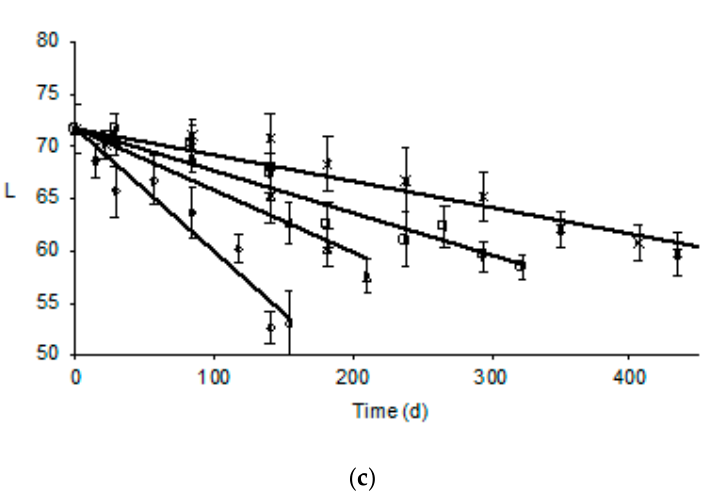
Figure 1. Changes of color ( L -value) of thawed ( a ) gilthead sea bream fillets, ( b ) sea bass fillets and ( c ) yellowfin tuna slices during storage at − 5, ∆ − 8, − 12 and ∗ − 15 °C. (Error bars indicate standard error of measurements of three different samples.) (1 a : R 2 − 5°C = 0.822, R 2 − 8°C = 0.820, R 2 − 12°C = 0.939, R 2 − 15°C = 0.937; 1 b : R 2 − 5°C = 0.986, R 2 − 8°C = 0.938, R 2 − 12°C = 0.852, R 2 − 15°C = 0.932; 1 c : R 2 − 5°C = 0.822, R 2 − 8°C = 0.820, R 2 − 12 ◦ C = 0.939, R 2 − 15 ◦ C = 0.937).